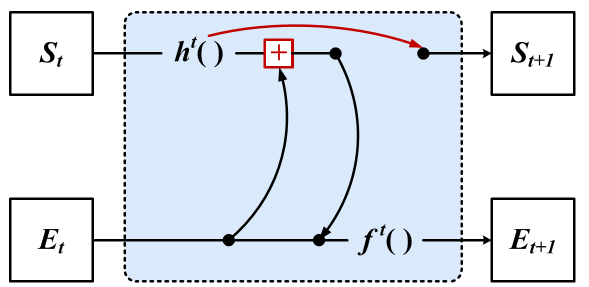
Figure 7. The feature aggregation method.